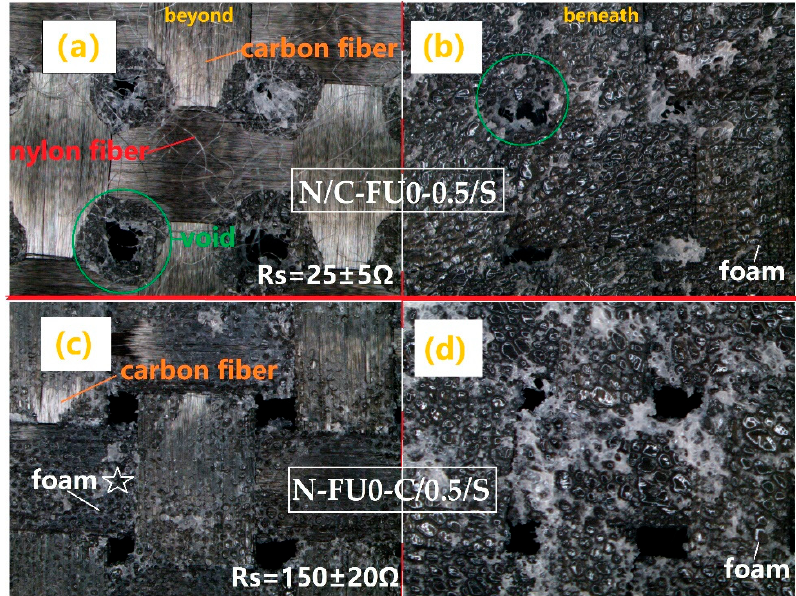
Figure 8. Microscopic images of interface beyond and beneath the carbon fabric. ( a ) Beyond the carbon fabric of N/C-FU0-0.5/S, ( b ) beneath the carbon fabric of N/C-FU0-0.5/S, ( c ) beyond the carbon fabric of N-FU0-C/0.5/S, and ( d ) beneath the carbon fabric of N-FU0-C/0.5/S.